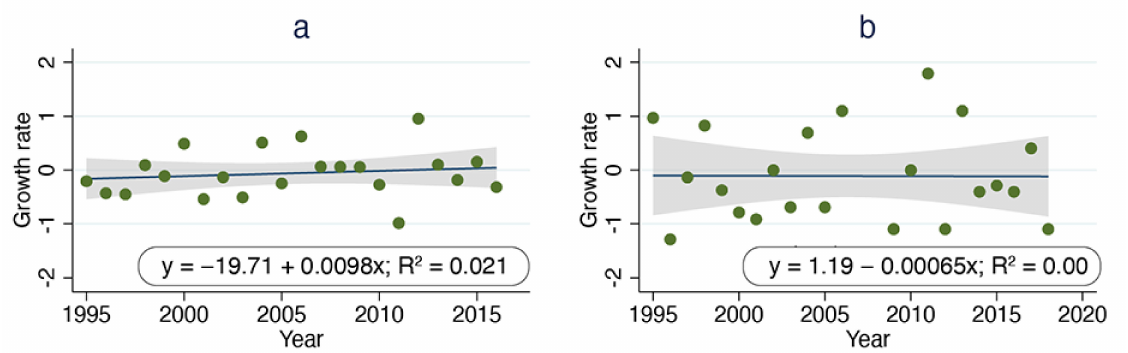
Figure 2. Calculated per capita growth rate over time, ORCAT program 1995–2016 ( a ) and UCF program 1995–2018 ( b ). Dark blue lines are best-fit lines derived from linear regression.